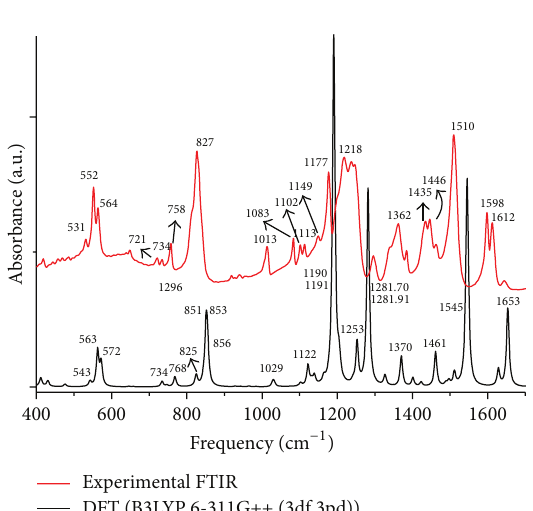
Figure 2: FTIR (400–1700 cm −1 ) spectra of “Bisphenol A” along with DFT spectra. Values of some peaks are given near the tip of the respective